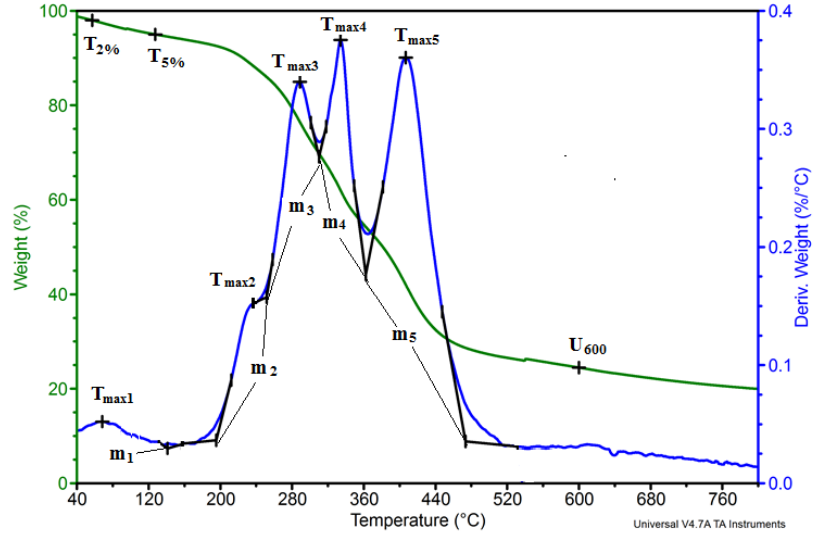
Figure 3. BCP thermogram.